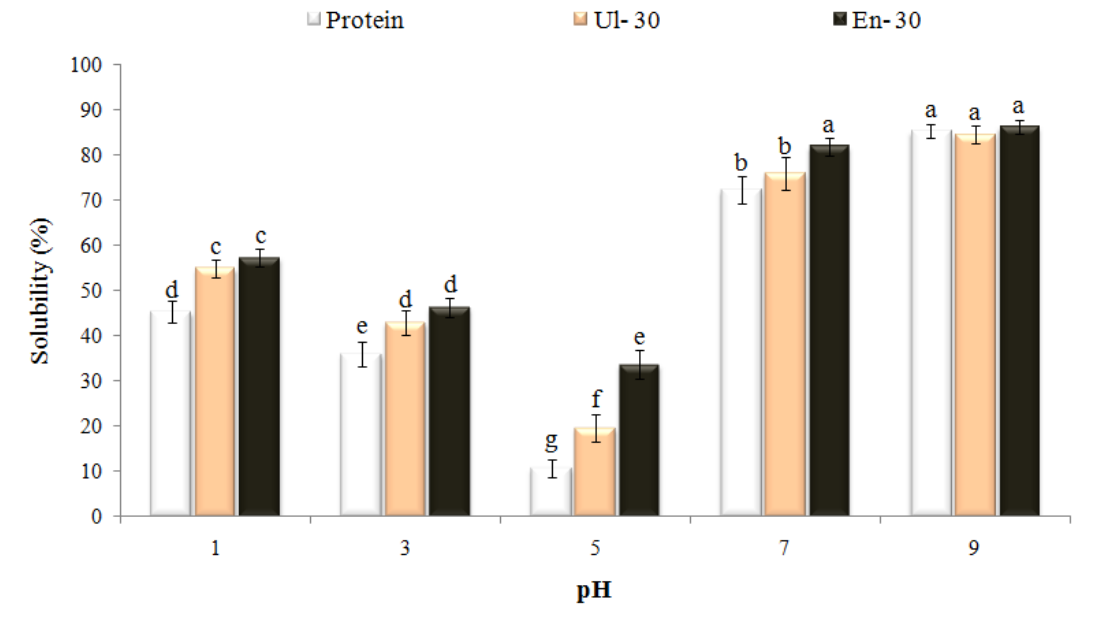
Figure 2. Effect of pH on the solubility of WPC modified by sonication or enzymolysis for 30 min (Ul-30/H-30). Data are presented as mean ( n = 3) with standard deviation (the same letters above bars indicate that the differences between average values were statistically not significant p < 0.05).